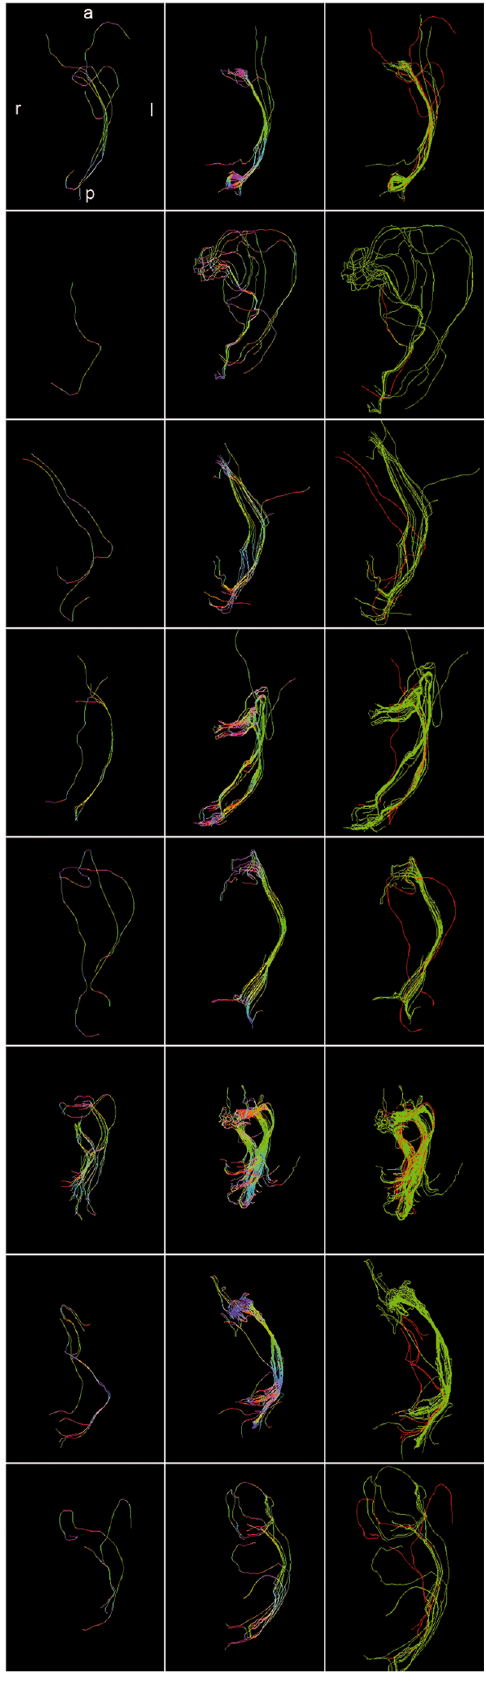
Figure 1. Fiber tractography results presented for each patient (patients 1–8 according rows 1–8) based on DTI (column 1), Slicer 4 (column 2), and based on HARDI + CS (column 4) within MedAlyVis. Overlay of DTI-based (red) and HARDI + CS-based tracto- graphy (green) (r=right; l=left; a=anterior; p=posterior).